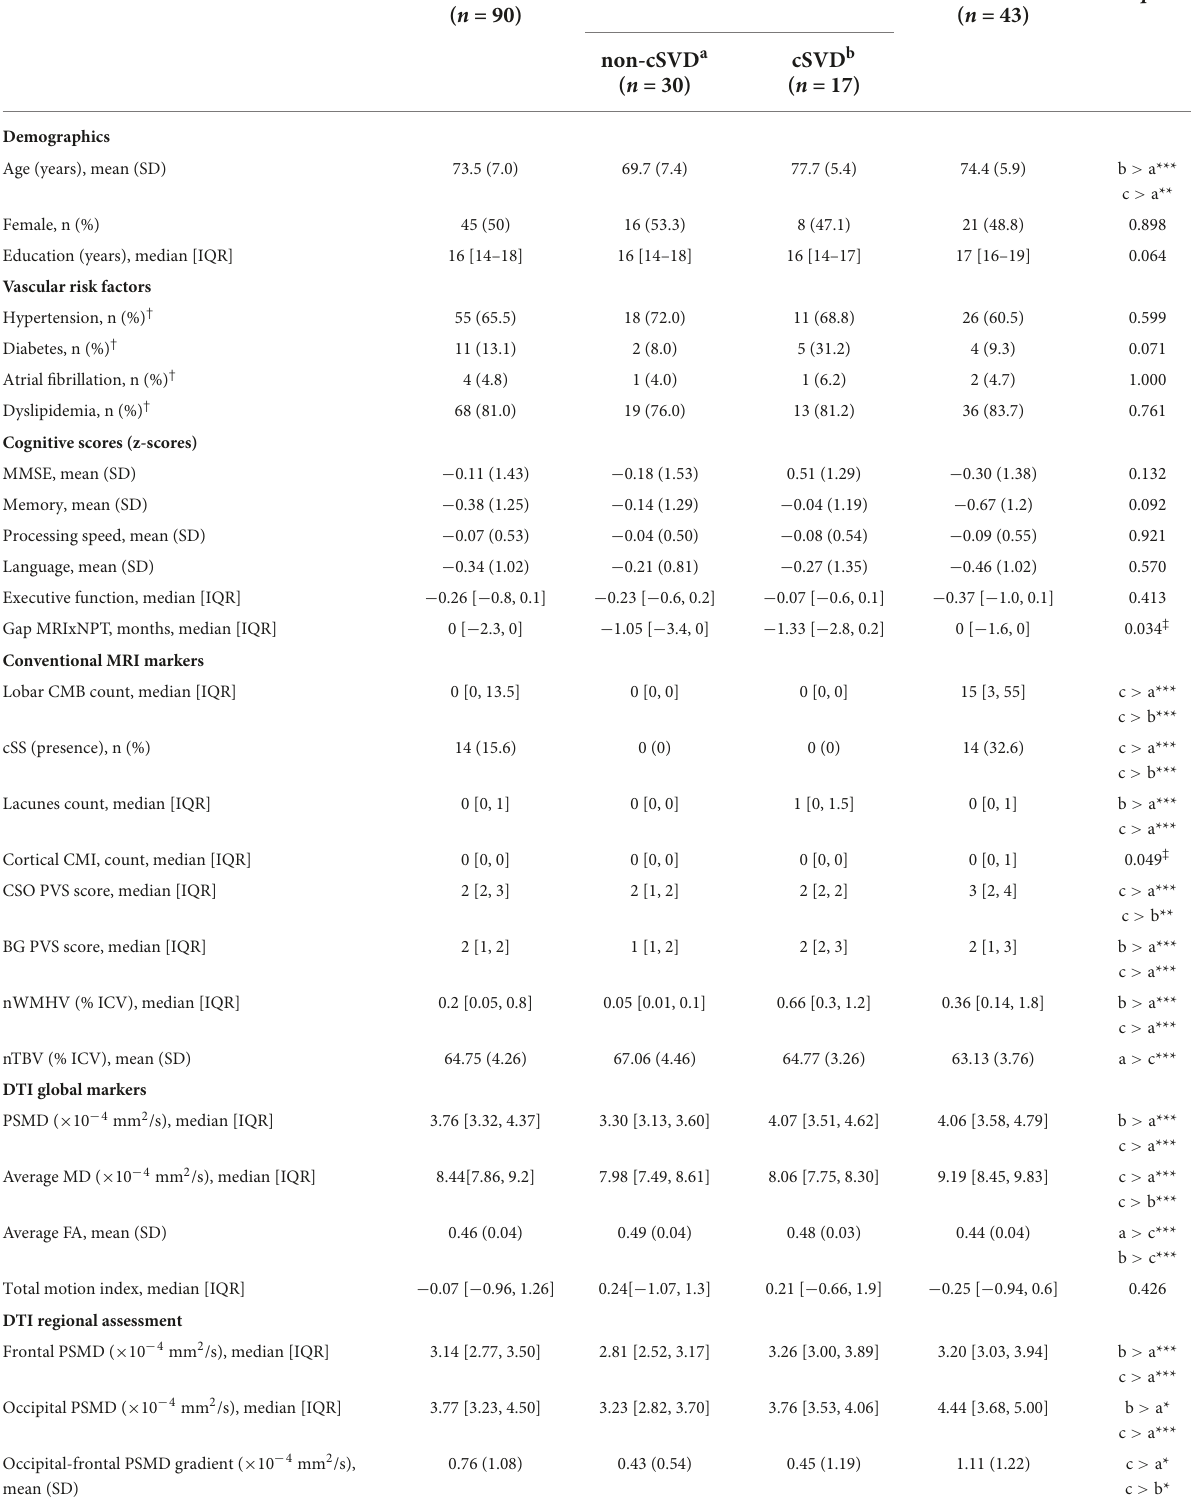
TABLE 1 Summary of clinical and neuroimaging